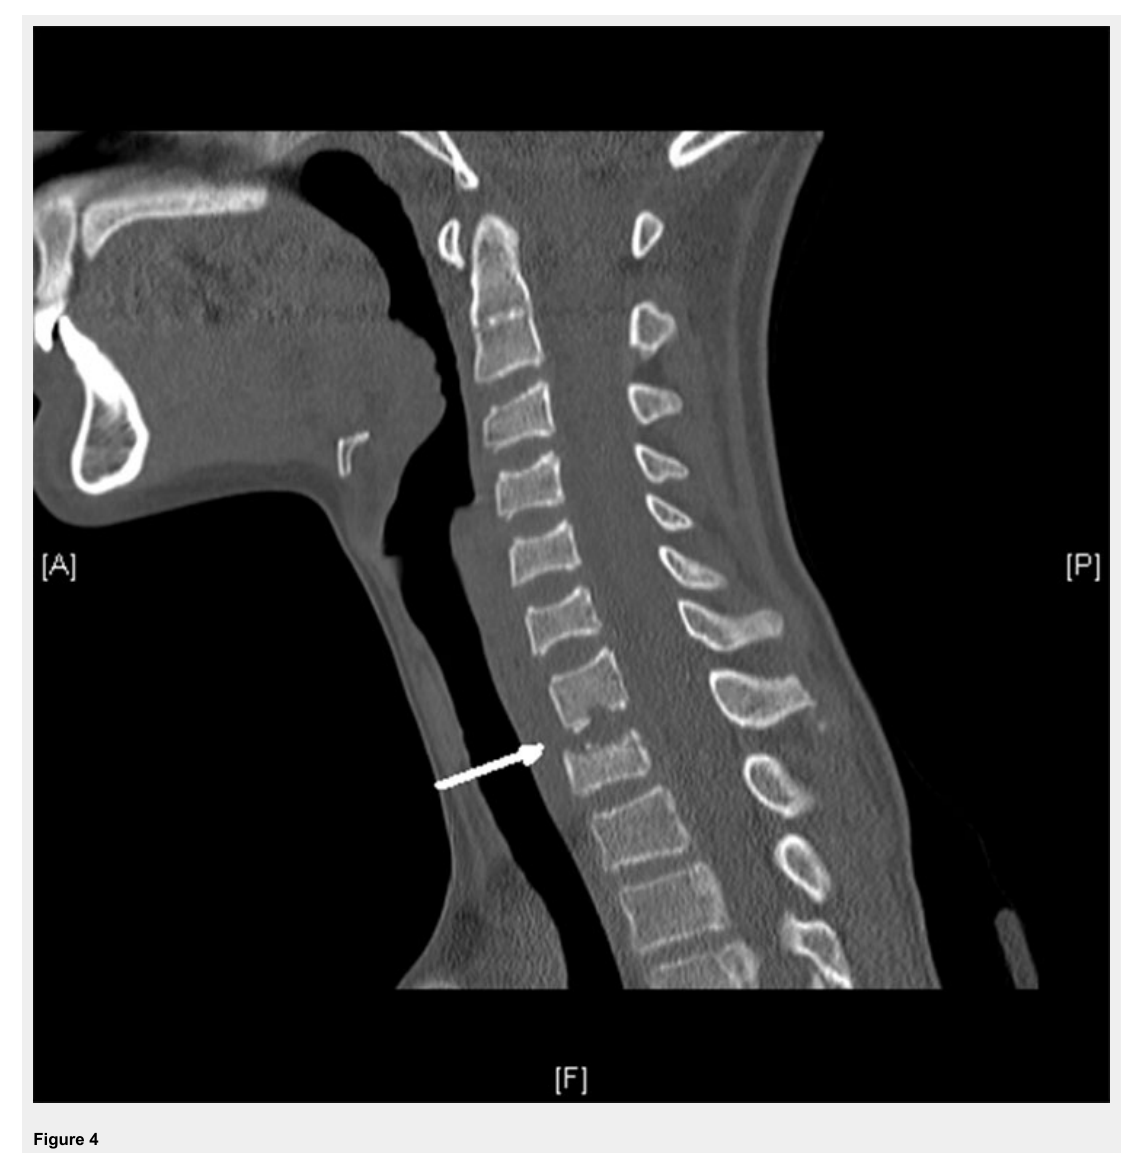
Figure 4 ( B ) in supine position. He presented with neck pain, without neurologic compromise but with difficulties to swallow due to a prevertebral haematoma as visible on the MRI ( C ). 3 months in a halo followed by 4 weeks in a supportive collar led to full